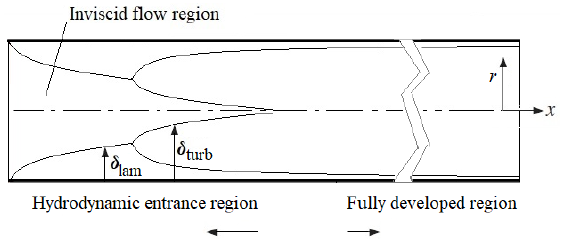
Figure 1. Hydraulically developing turbulent flow in the tube. Turbulent